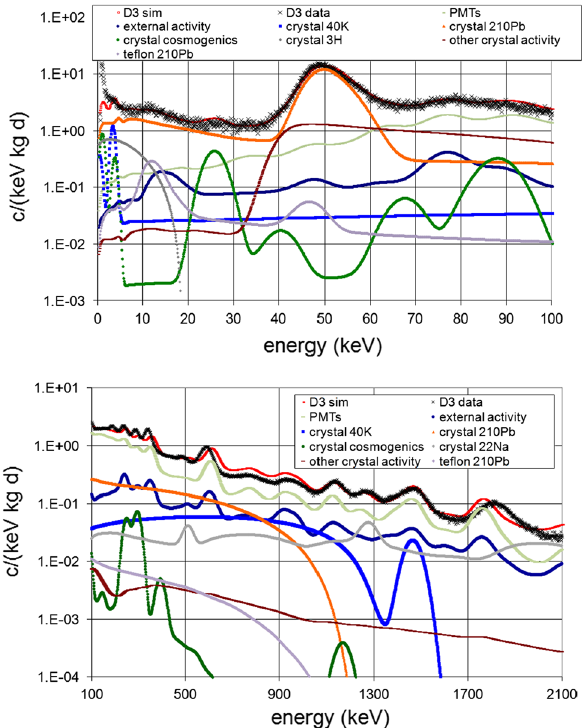
Fig. 12 Energy spectra expected from individual background sources, together with the sum of all of them and the measured background. Results are presented for D3 detector, for anticoincidence spectra in the low energy range as in Fig. 10 (top) and for total spectra in the high energy region as in Fig. 8 (bottom). The measurement and simulations correspond to the first year of data taking. The shown low energy data correspond to the 10% of unblinded data for that